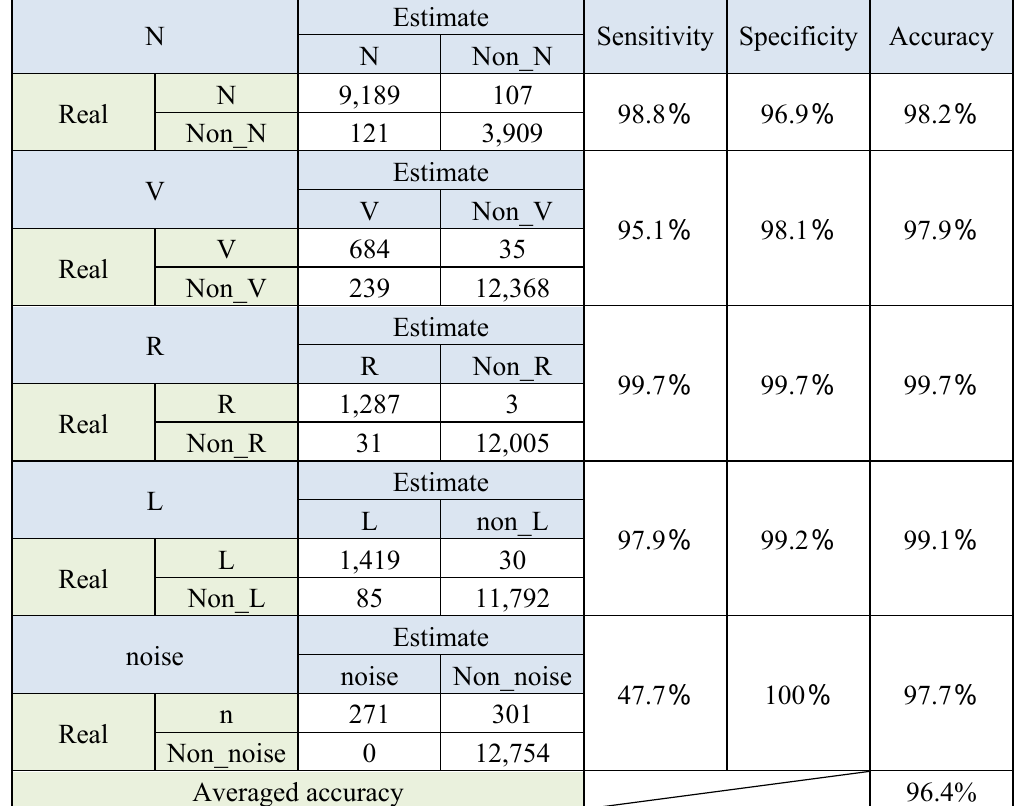
Table 4. Statistical values of the SoNFIN classification results of the test phase in second